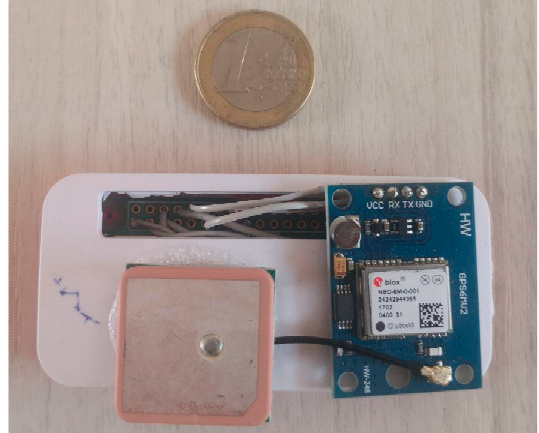
Figure 8. Raspberry-based IMU device.